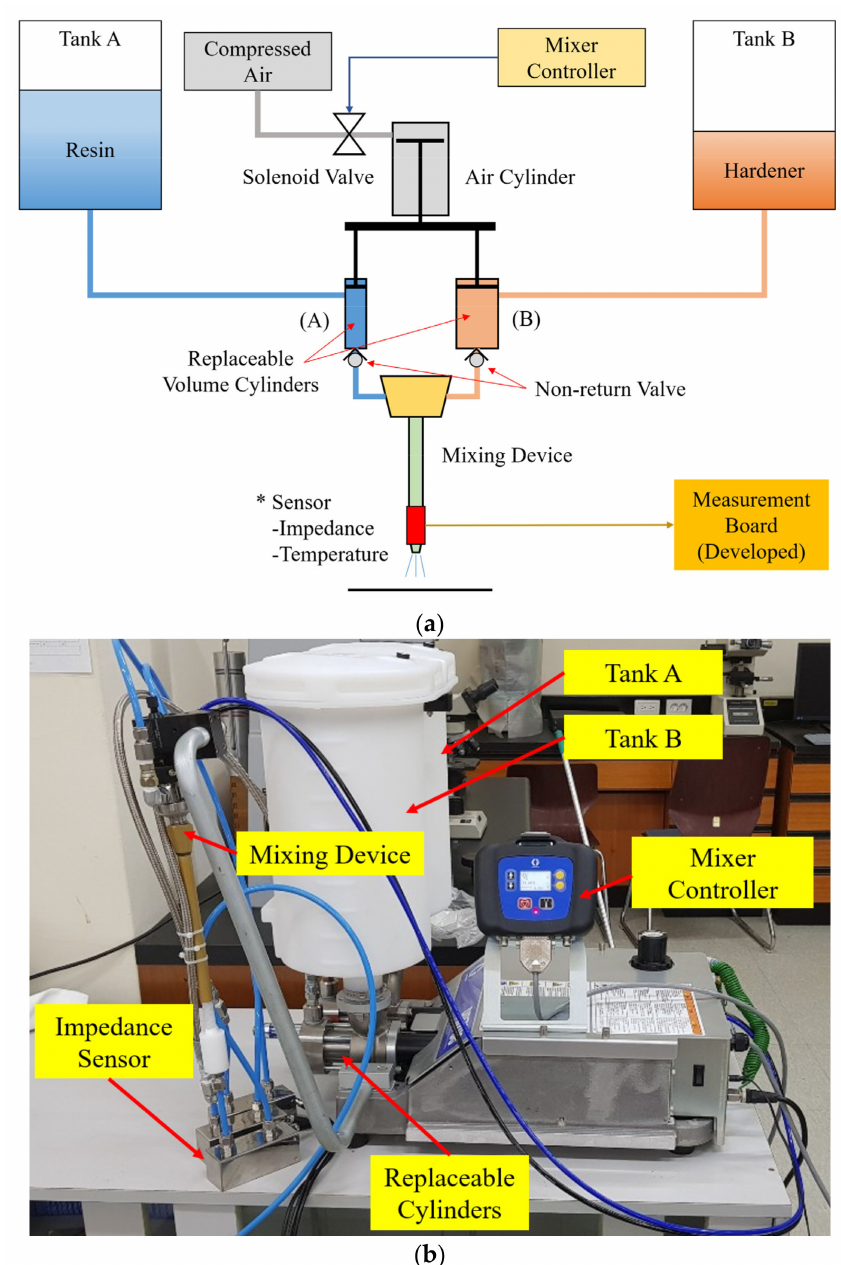
Figure 14. The composition of the experimental device: ( a ) Fixed ratio two-part epoxy adhesive mixing device with sensor; ( b ) A picture of the experimental